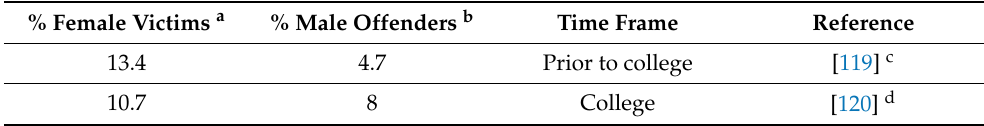
Table 2. Percentage of rape victims and offenders reported in Kanin et al. % Female Victims